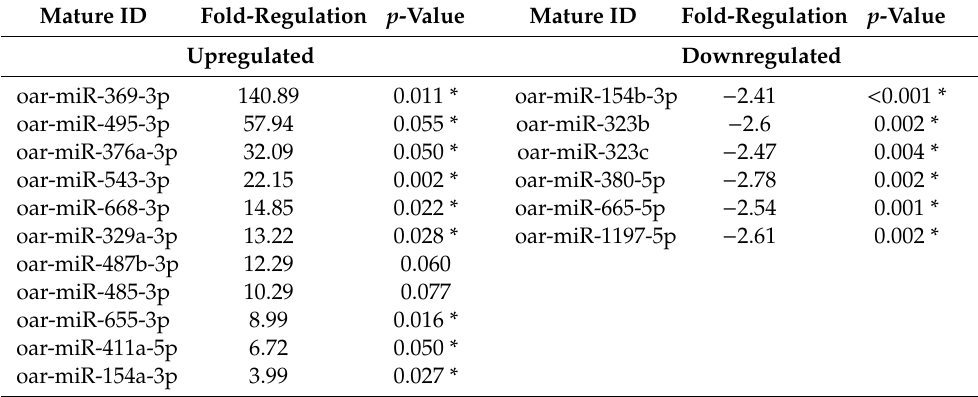
Figure 1. Fold-change expressions of 7 individually analyzed ovine microRNAs: ( a ) miR-200b, ( b ) miR-223, ( c ) miR-1246, ( d ) miR-29b, ( e ) miR-145, ( f ) miR-31, and ( g ) miR-130b at 0 and 4 h post-LPS-challenge (400 ng/kg i.v.). Significance between time points is denoted by (**) for p < 0.01 and (***) for p < 0.005. Table 1. Di ff erentially expressed ovine serum miRNA 4 h post-systemic LPS challenge. * indicates significance at p <